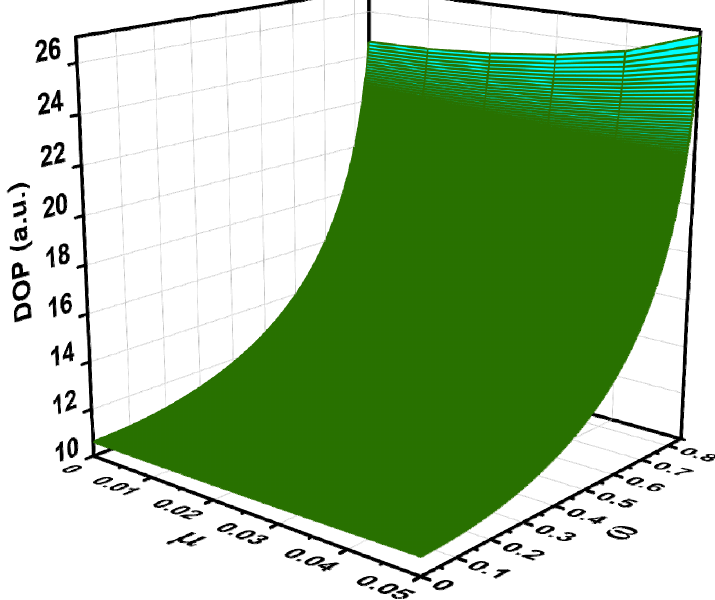
Figure 3. The dynamic octupole polarizability (DOP) as a function of the screening parameter and photon frequency.